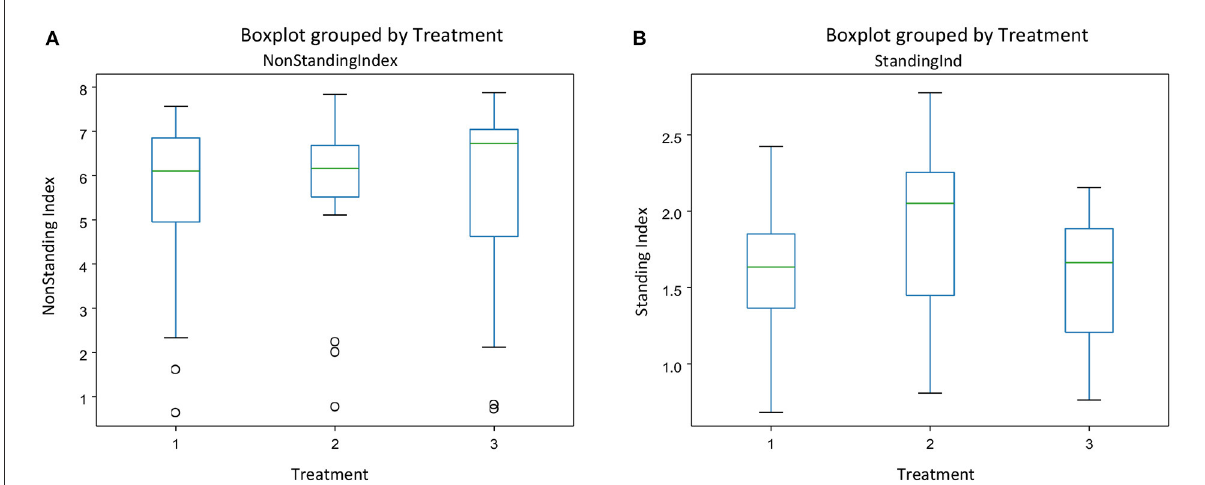
FIGURE4 The behavioral indices for Non-standing (A) and standing behavior (B) for each treatment across experimental days in pens of pigs receiving different dietary treatments. Weaner pigs received dietary treatments with added ZnO (T1), non -supplemented control (T2) or added antibiotics (T3). The plots are depicting groups of numerical data through their quartiles. The box extends from the Q1 to Q3 quartile values of the data, with a line at the median (Q2). The whiskers extend from the edges of the box to show the range of the data.